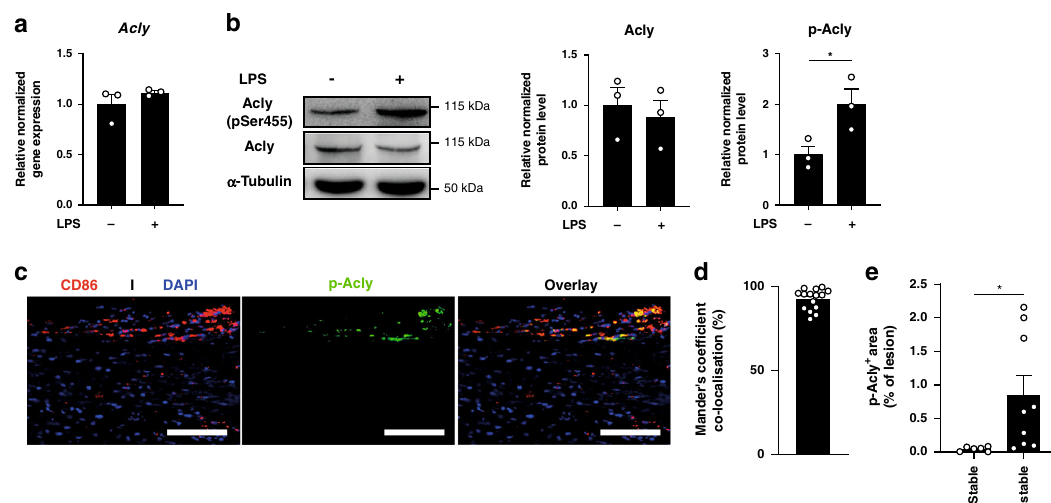
Fig. 1 Acly is phosphorylated in in fl ammatory conditions in vitro and in vivo. a Relative normalized expression of Acly in unstimulated and LPS- stimulated macrophages. b Normalized protein levels from cell lysates of unstimulated and LPS-stimulated macrophages. Samples were immunoblotted with antibodies against Acly, phosphorylated Acly (p-Acly) and α -tubulin. Acly/p-Acly quanti fi cation on the blots derive from samples of the same experiment and gels/blots were processed in parallel. * P = 0.0441. c Representative immunohistochemical staining for macrophages (CD68) and p-ACLY in human plaques from 16 stable/unstable plaques. Scale bar represents 100 µ m. d Quanti fi cation of colocalization, percentage of p-Acly + macrophages overlapping with CD68 + area. e Quanti fi cation of p-Acly + area in the lesion. * P = 0.0402. Values represent mean ± SEM ( n = 3 technical replicates of three pooled mice a , n = 3 one representative image of three technical replicates of three pooled mice ( b , western blot), n = 7/9 stable/unstable plaques d , e . * P < 0.05; by two-tailed Student ’ s t test ( b , e ). Source data are provided as a Source Data fi le ( a – e